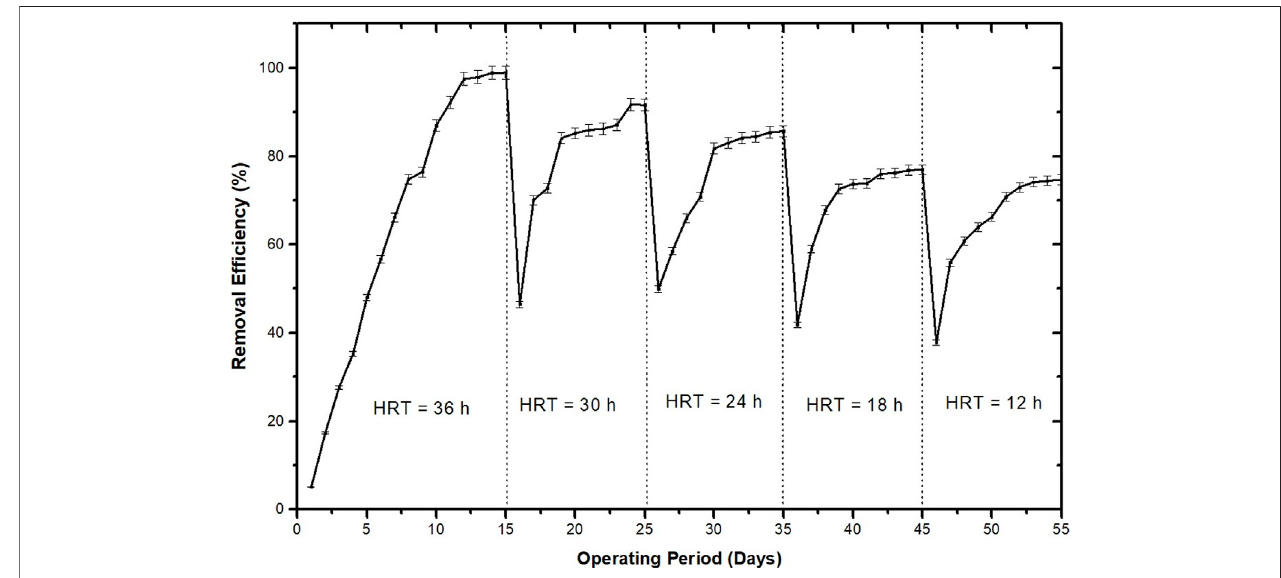
FIGURE 2 | Effect of HRT on butachlor removal ef fi ciencies of the PBBR.